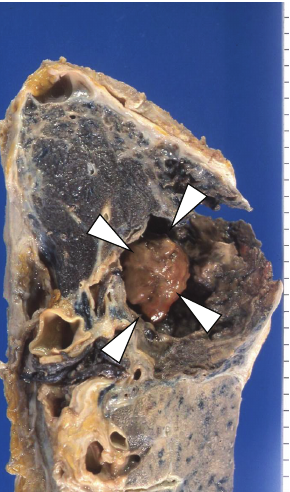
Figure 6: Chronic pulmonary aspergillosis. There is a cavity filled with fungus (white arrow head) surrounded by the secondary or-